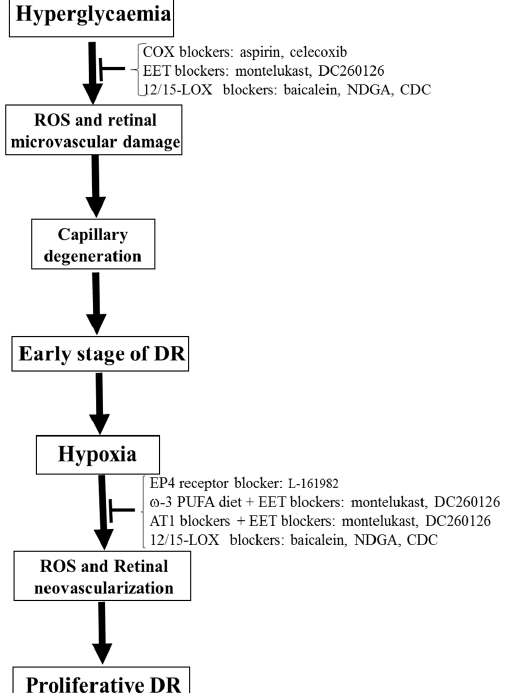
Figure 6. General mechanisms for the development of the early stage of DR and proliferative DR. We also indicate the potential therapeutic methods of the eicosanoid pathways to prevent the development of the early stage of DR and proliferative